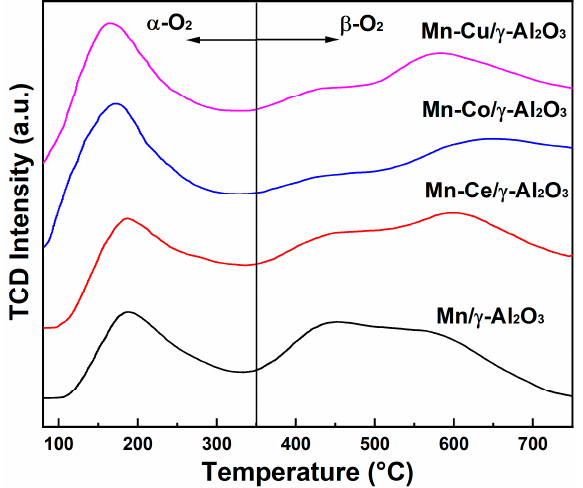
Figure 4. O 2 -TPD profiles of Mn-X/ γ -Al 2 O 3 catalysts.